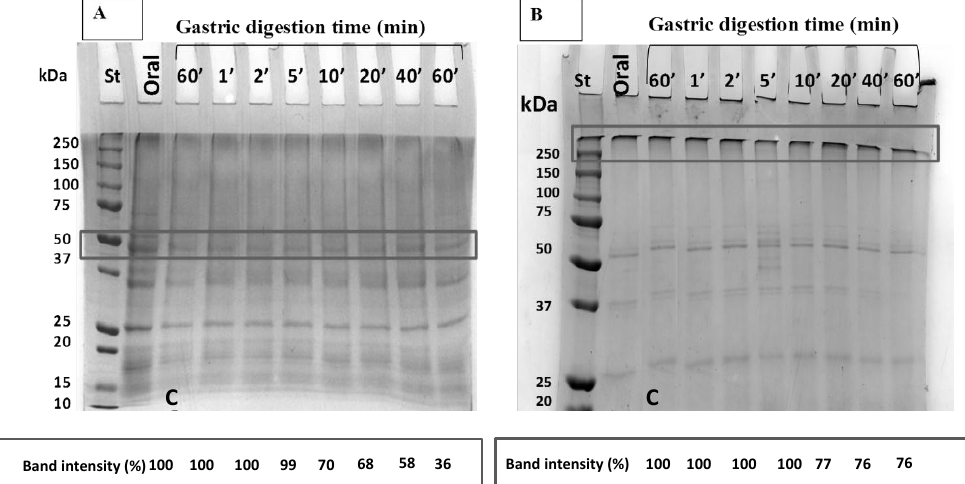
Figure 4. ( A ) Oral and gastric in vitro digestion and densitometry analysis of 50 kDa protein bands of grass pea film cast without mTGase; ( B ) Oral and gastric in vitro digestion and densitometry analysis of protein bands of >250 kDa of grass pea film cast in the presence of mTGase (33 U/g). C is control sample incubated without pepsin. St, Molecular weight standards, Bio-Rad.